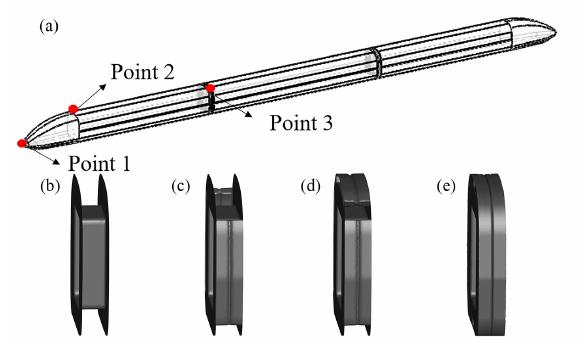
Fig. 2. Computational model: (a) Vehicle grouping model (b) Inner windshield (c) Bodyside windshield (d) Body side and top windshield (e) Mechanical windshields.